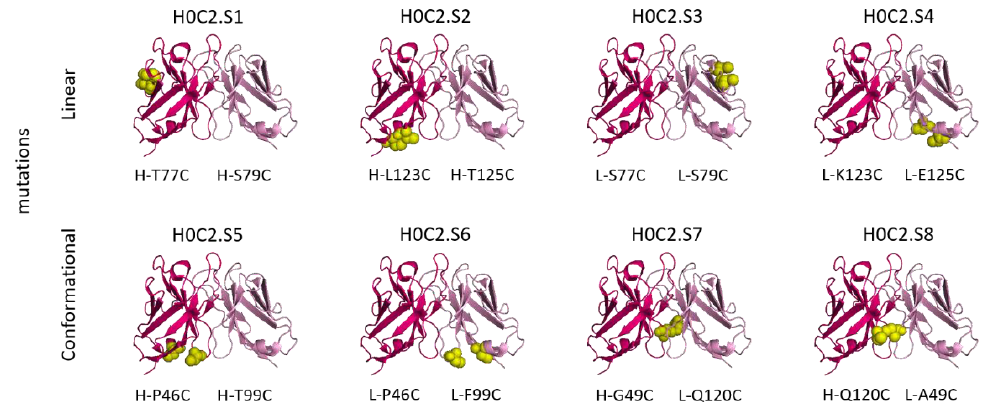
Figure 2. Cysteine positions for the eight different antibody fragments H0C2.Sx (x = 0 to 8) used for the bioconjugation of linker-MMAF 1 . We used the 1N8Z.pdb file, with the VH in hot pink, the VL in pink, and the cysteines in yellow.